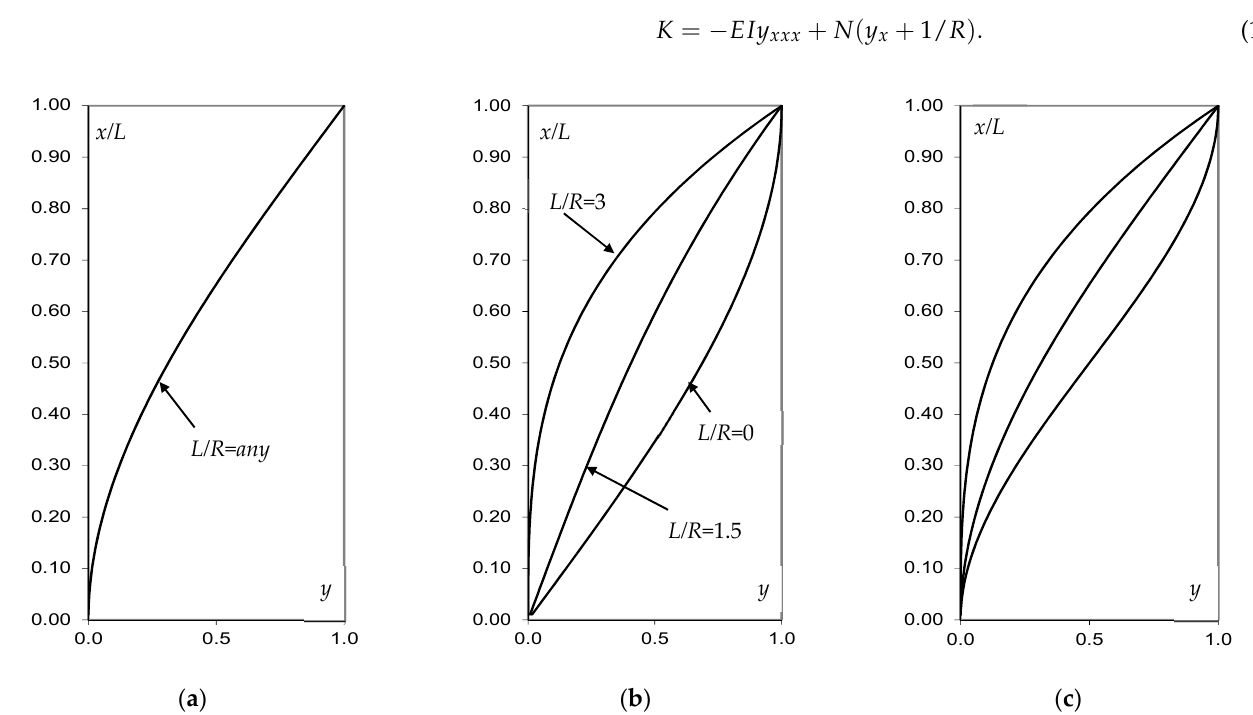
Figure 2. Elastic rod shapes for various connection schemes: ( a ) rigid–pinned, ( b ) pinned–rigid, ( c ) rigid–rigid.